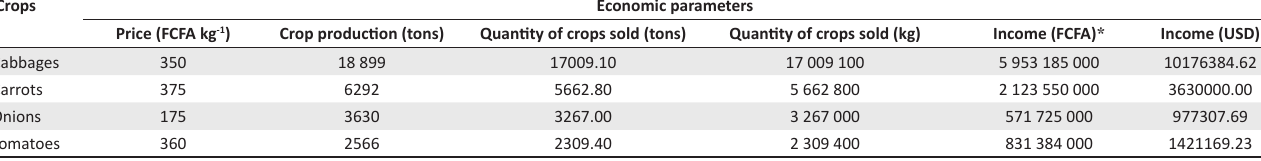
TABLE 4: Estimate of income generated per vegetable crop produced.